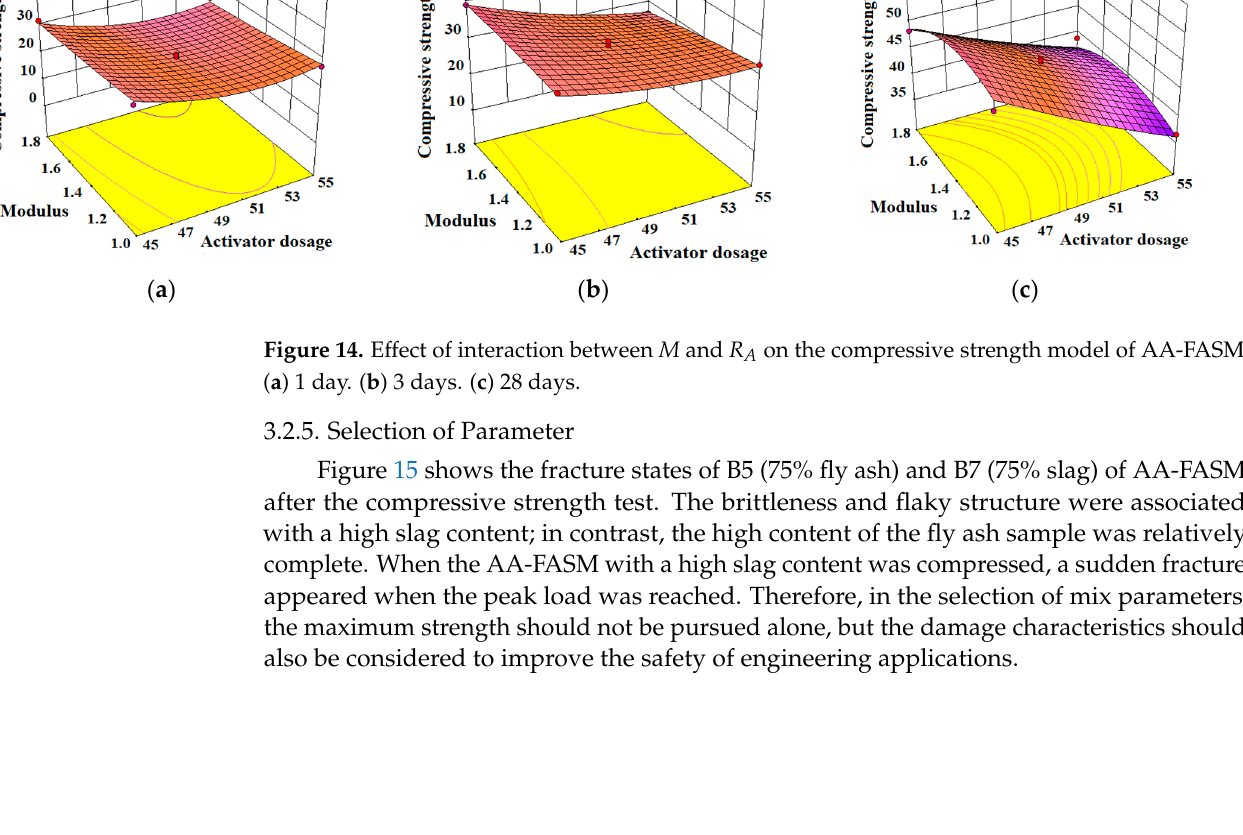
Figure 15. Comparison of the fracture state of B5 and B7 of AA-FASM after compressive strength. Figure 16 shows the comparison of the cracks between B1 and B3. Compared with B1 ( W SG = 25%) without cracks, a denser curve or arc crack network appeared on the surface of B3 ( W SG = 75%). The presence of microcracks indicated that it has great shrinkage sen- sitivity. It is generally believed that the hardened paste of the alkali-activated material is mainly composed of gels [36,46], which give it higher compressive strength but also higher shrinkage. Reference [47] also points out that the large shrinkage of sodium silicate- activated slag is associated with the dehydration of silica gel with a high water content or silica-rich gel products.